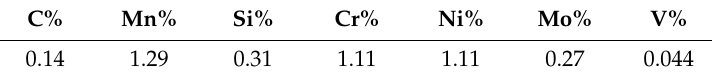
Table 1. Composition of the S690 steel (wt.%).